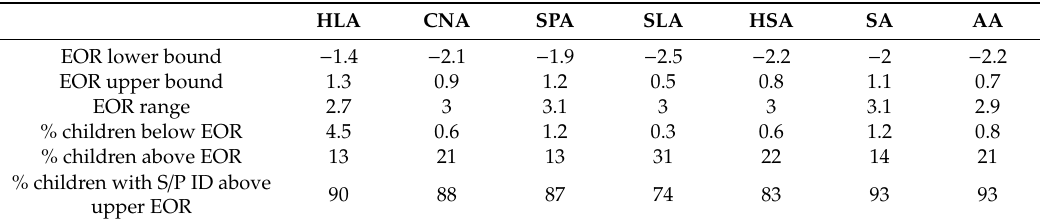
Table 5. Effective operational ranges and scores distribution. Table 5. E ff ective operational ranges and scores